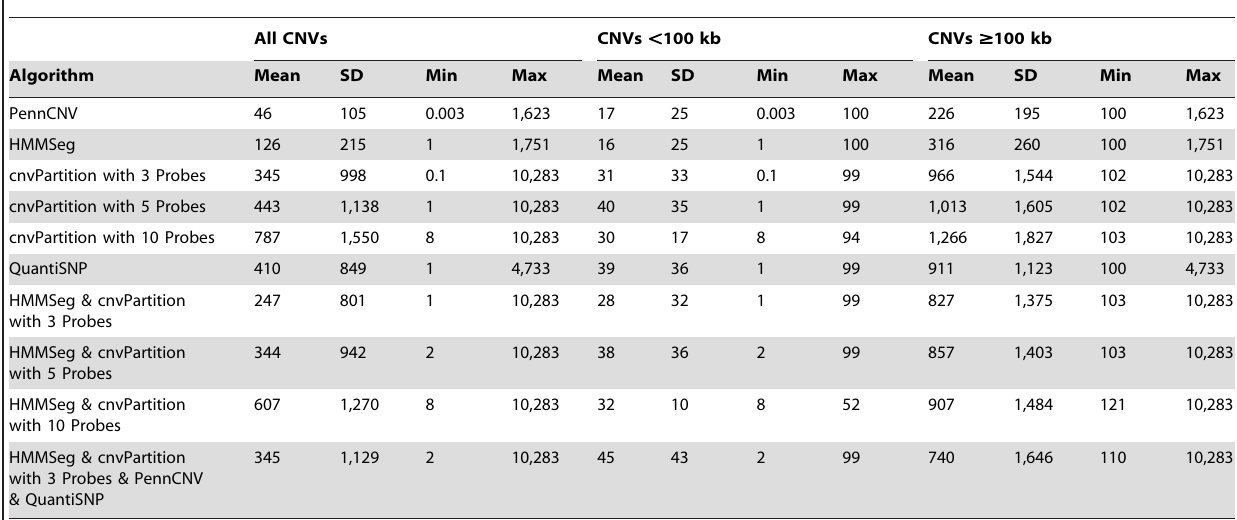
Table 3. Size of CNVs (kb) detected in 96 subjects by each